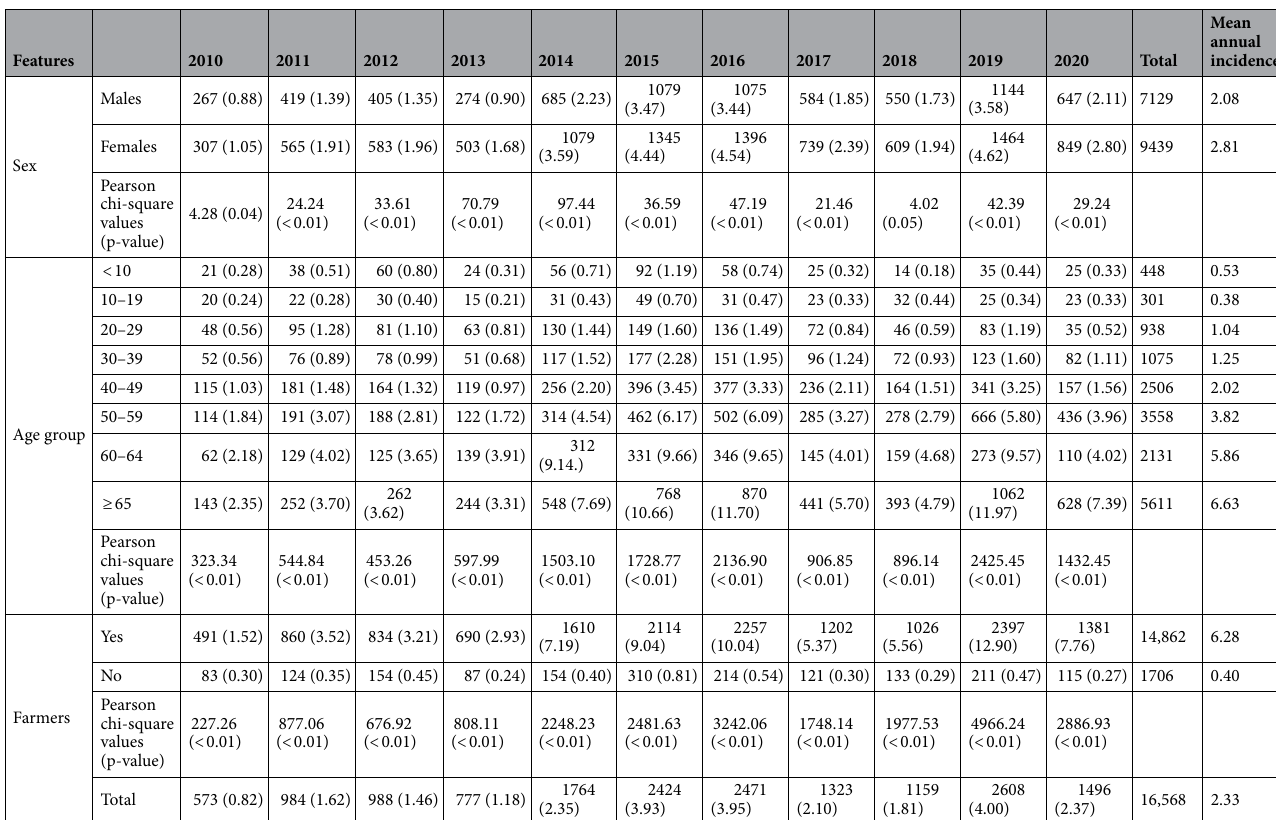
Table 1. Annual number of scrub typhus cases and incidence rate by gender, age and occupation in Anhui province, China, 2010–2020.